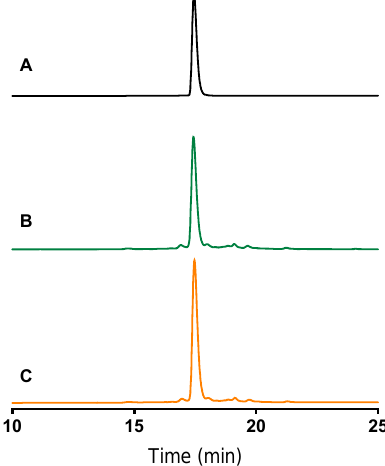
Figure 3. Analytical RP-HPLC chromatograms resulting from injection of ( A ) synthetic ω -Avsp1a; ( B ) native ω -Avsp1a, and ( C ) both the native and synthetic forms. The two forms co-elute, indicating that the synthetic peptide is correctly folded. Column: Thermo Hypersil C18 GOLD 100 × 2.1 mm, 3 μm, 175 Å. Conditions : 10 to 55% solvent B over 30 min, column heated at 40 °C, UV detection at 214 nm.